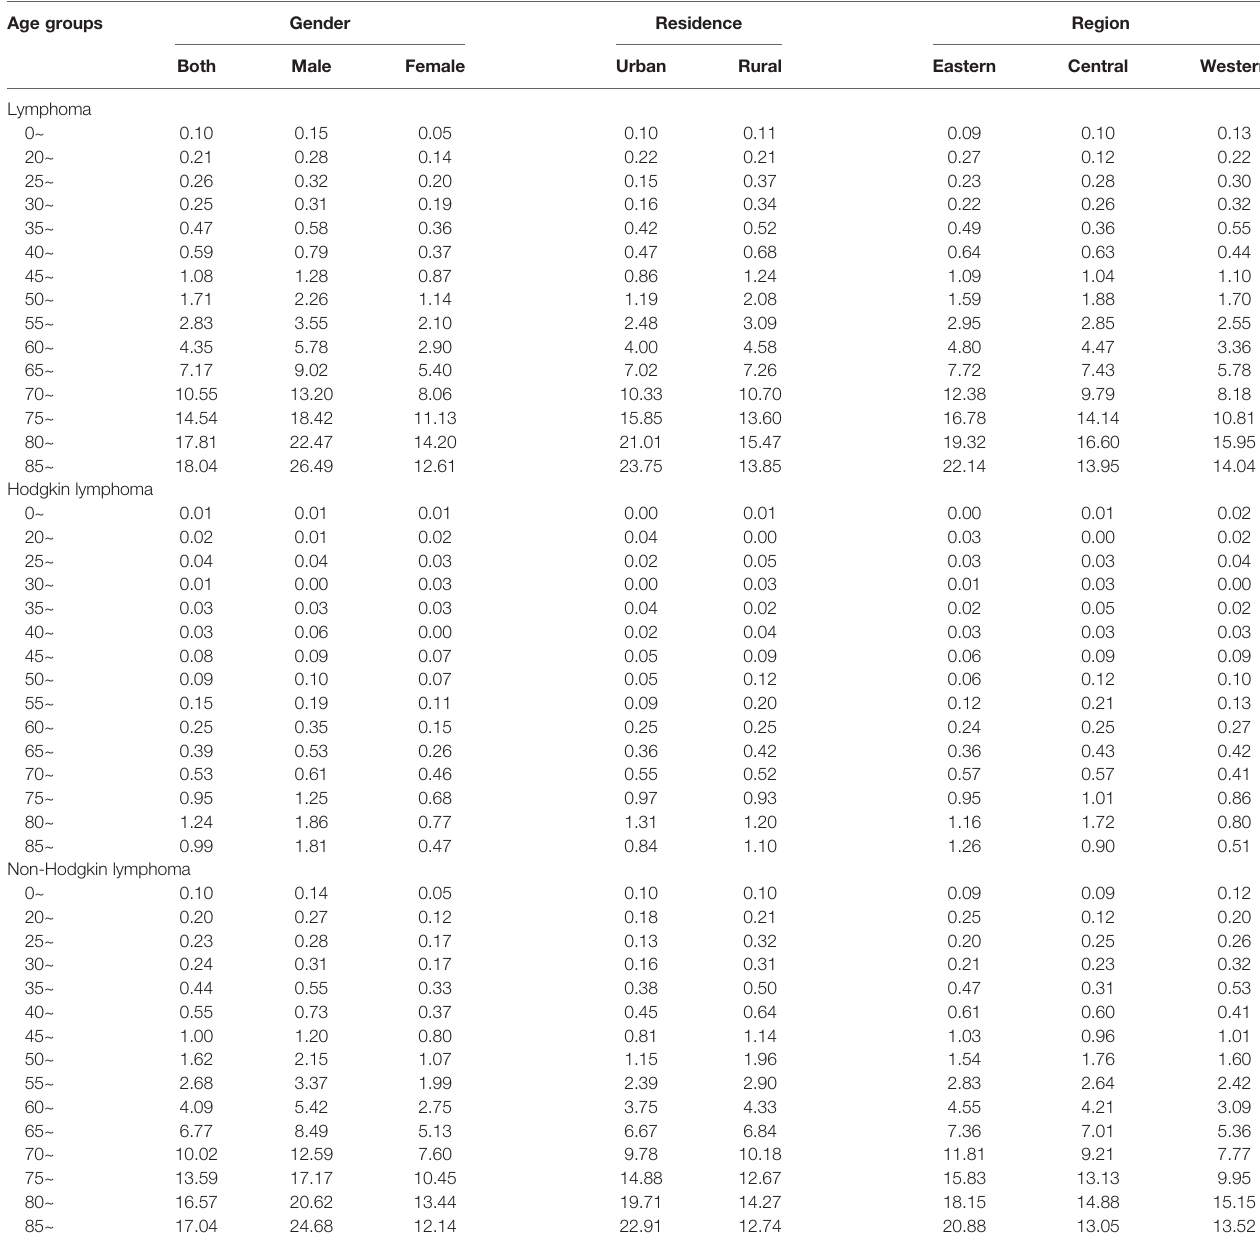
TABLE 2 | Mortality rate of lymphoma strati fi ed by age, sex, region and residence, 2020. Age groups Gender Residence Region Both Male Female Urban Rural Eastern Central Western Lymphoma